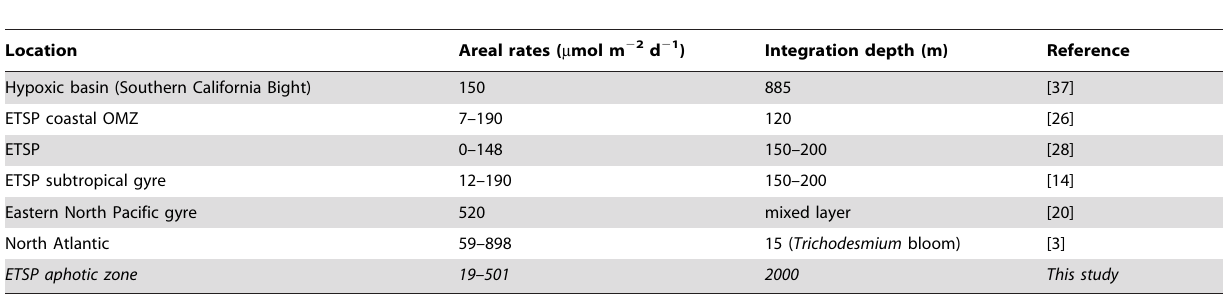
Table 2. Examples of published studies showing the range of oceanic N 2 fixation areal rates measured in some contrasting oceanic environments.